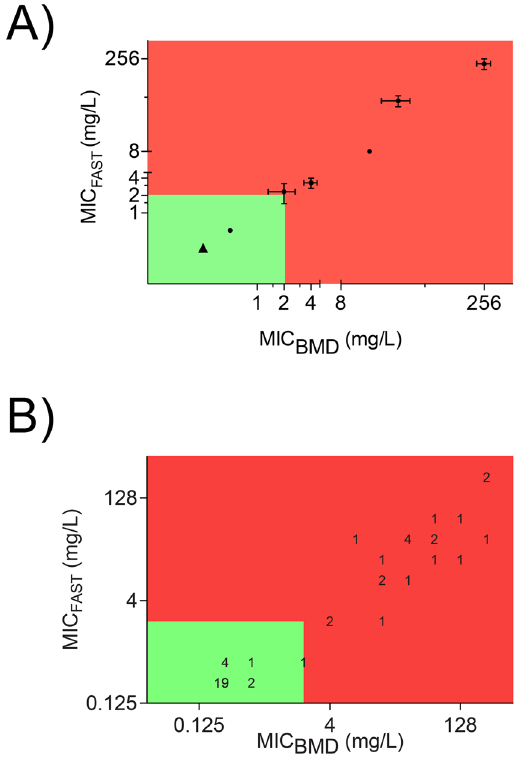
Figure 4. FAST accurately predicted MIC BMD across our collection of K. pneumoniae isolates. Coloured regions represent the qualitative susceptibility (green)/non-susceptible (red) determination of ( A ) the initial 10 isolates tested (mean MIC BMD/FAST and SEM), a strong positive correlation was observed (r = 0.899, p < 0.0001), represents four isolates, all with perfectly concordant MIC BMD , FAST coordinates. ( B ) Full 48 isolate collection. Numerals indicate the number of isolates occupying the same MIC BMD , MIC FAST coordinates. Across the full collection of isolates, a strong positive correlation was observed (Matthew’s correlation co-efficient =